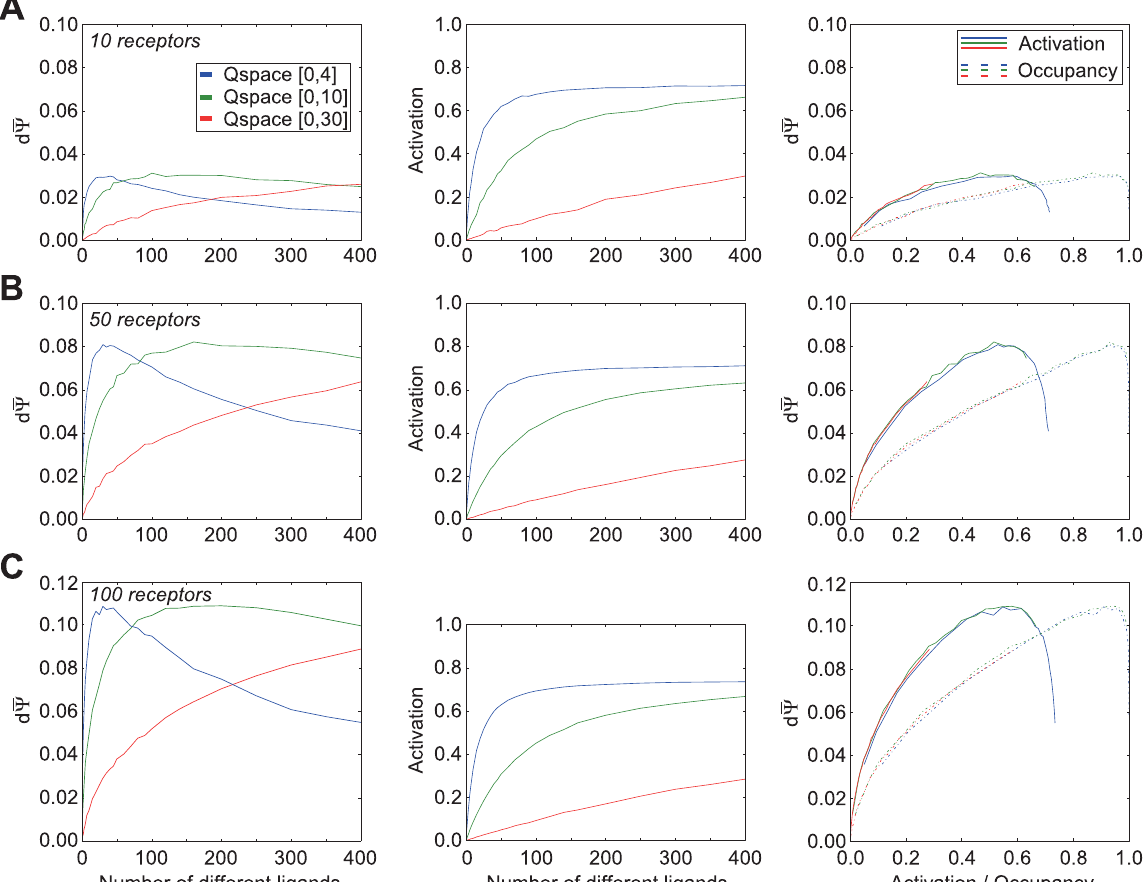
Fig 6. Effects of increasing the number of deployed receptors. In contrast to the nonmonotonic effects of increasing the number of ligands, increasing the number of receptor types deployed in a Q-space correspondingly improved the mean discrimination capacity in all cases. A. Receptor activation and discrimination capacity as a function of the number of ligands in a Q-space with ten receptors deployed. B. As panel A, but with 50 receptors deployed. C. As panels A-B, but with 100 receptors deployed. Compare also to Fig 5A, in which 30 receptors are